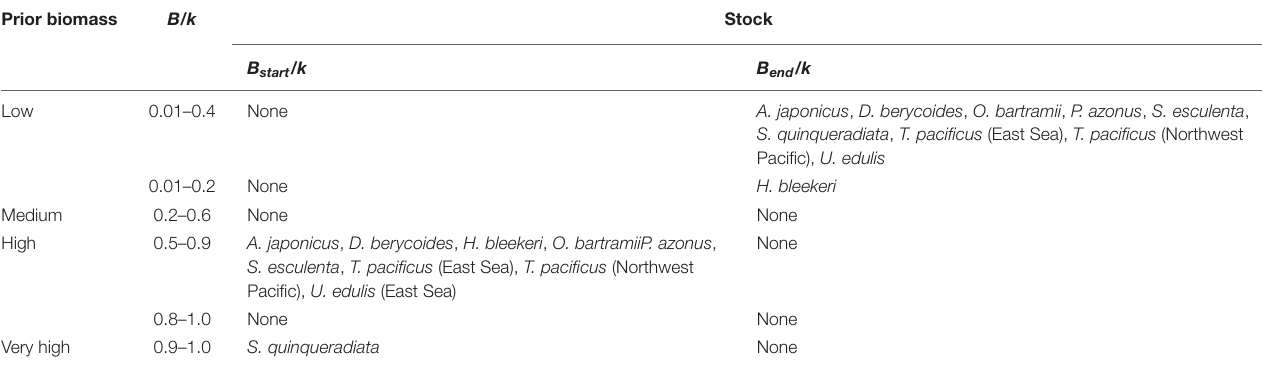
TABLE 3 | Default range of biomass relative to k at the start ( B start / k ) and the end ( B end / k ) of the time series of stocks under assessment. Prior biomass